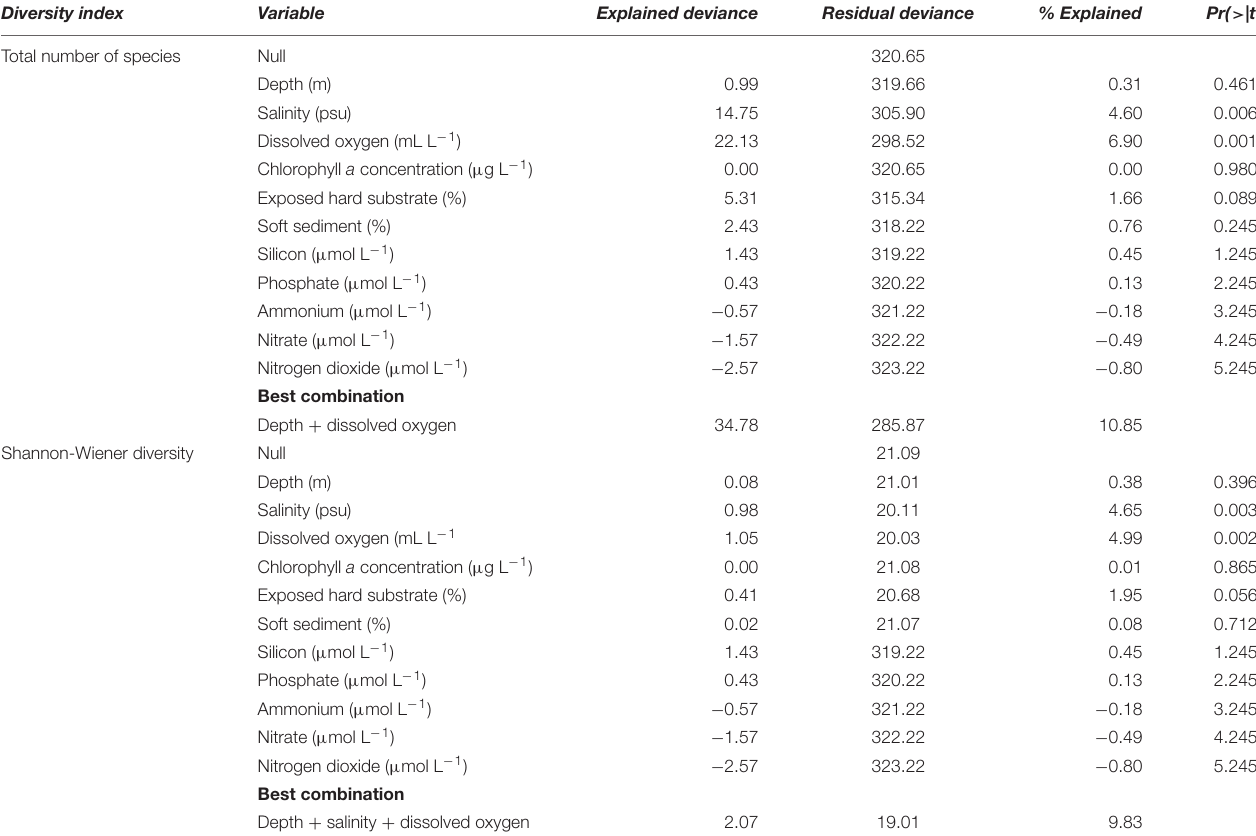
TABLE 4 | Summary statistics of the generalized linear models (GLMs) fitted to species richness and Shannon-Wiener diversity (Poisson distribution, quasi-Poisson error). Diversity index